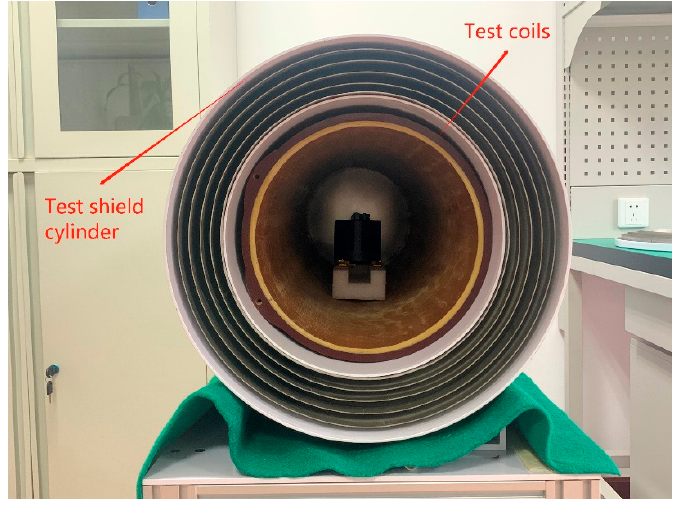
Figure 9. Test shield cylinder for determining the magnetic sensor performance.